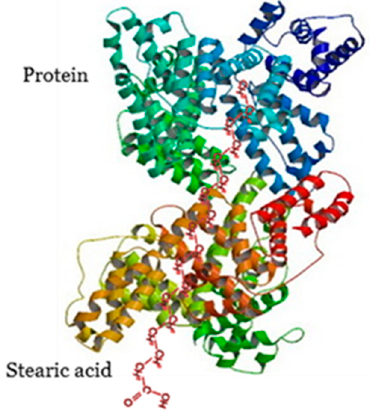
Figure 3. Proposed structure of stearic